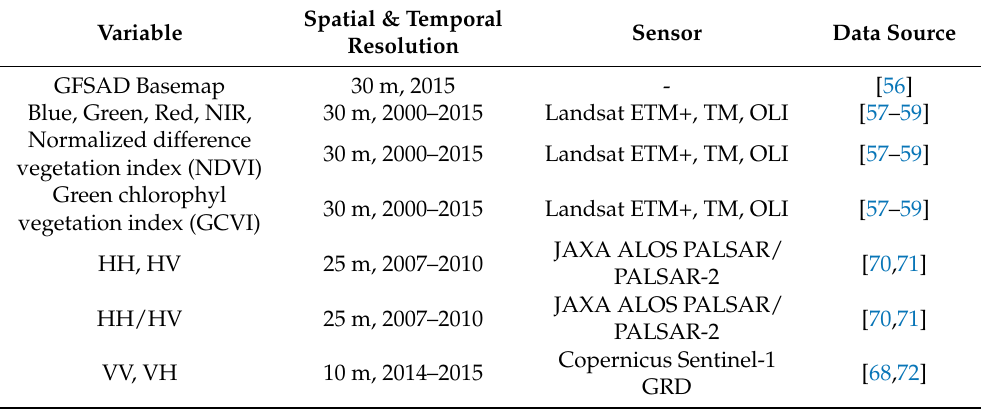
Table 1. Overview of our variable inputs including our GFSAD basemap; Landsat ETM+, TM, and OLI; JAXA ALOS PALSAR/PALSAR-2; and Copernicus